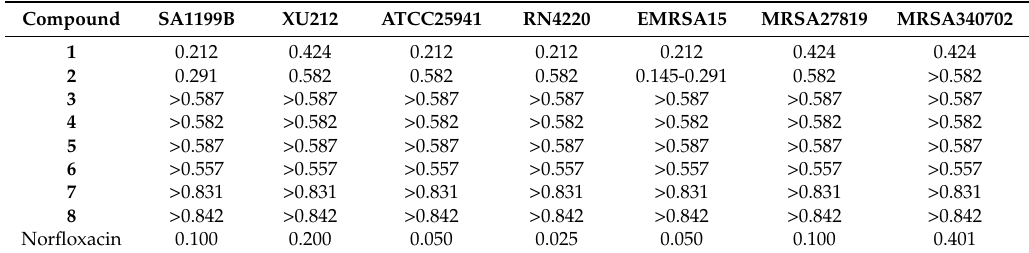
Table 4. Minimum inhibitory concentrations (MICs) (in mM) of compounds ( 1 – 8 ) against standard, multi-drug resistant (MDR) and methicillin-resistant strains of Staphylococcus aureus . Compound SA1199B XU212 ATCC25941